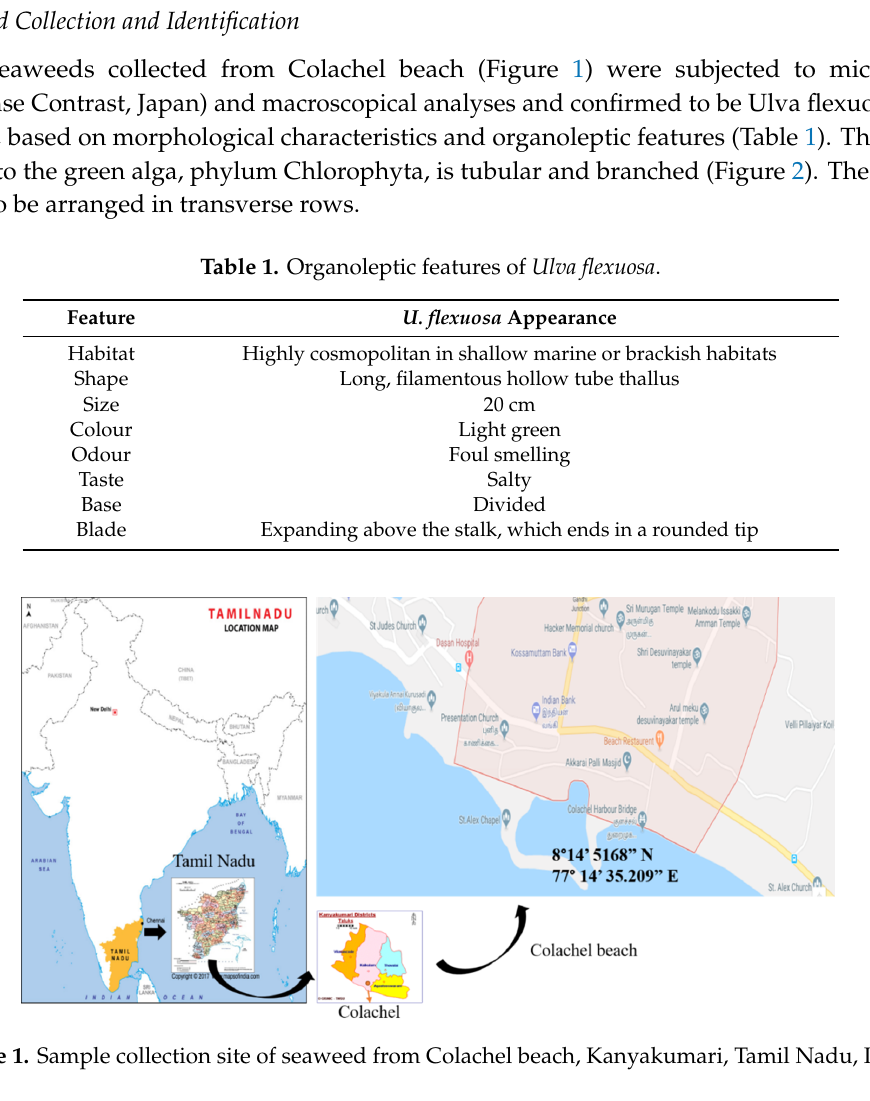
Figure 2. Macroscopic and microscopic images of U. flexuosa . ( A : Sample collection site, Colachel beach; B : U. flexuosa ; C & D : Macroscopic image; Microscopic image of U. flexuosa - E : 10×; F : 40× and G : 100×, showing blue coloured pigments on cell wall). 3.2. EF-LSE Analyses 3.2.1. Physicochemical Screening The EF-LSEs appeared as pale greenish yellow in colour. The pH of the EF-LSEs of doses 20%, 40%, 60%, 80% and 100% was measured and found to be 7.160, 7.240, 7.34, 7.4 and 7.58, respectively. The pH of control was 7 and that of SFS was 4.2. The electrical conductivity (EC) of the respective EF-LSE doses was recorded as 0.96 ds m − 1 , 1.01 ds m − 1 , 1.08 ds m − 1 , 1.54 ds m − 1 and 2.8 ds m − 1 , respectively (Table 2). Table 2. Physico-chemical properties of LSEs, pH and EC (dS m − 1 ). Treatments